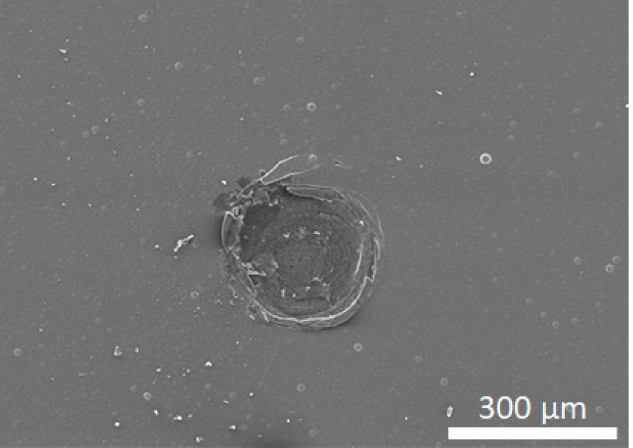
Figure 5. Adhesion testing of the coating by Rockwell C, with a load of 1250